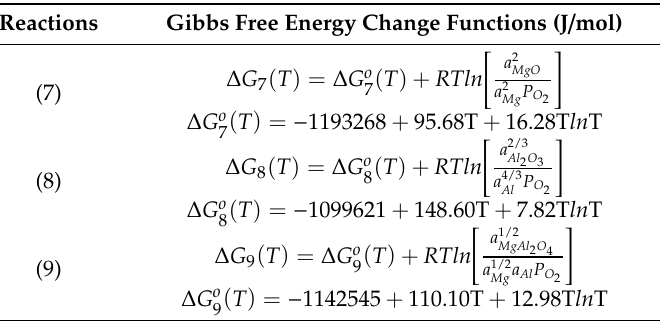
Table 3. Gibbs free energy change functions ∆ G i ( T ) associated with the reactions (7), (8) and (9), taking into account the standard free energy change ∆ G o from [28].